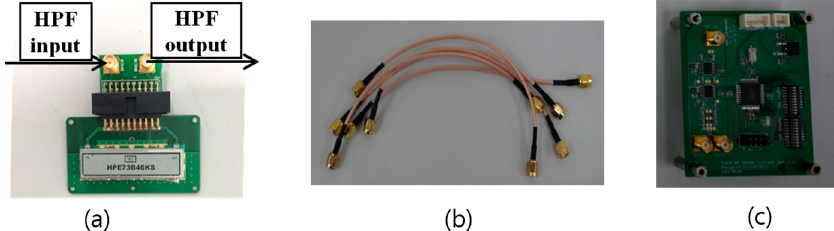
Figure 10. Submodules of IF, ( a ) high-pass filter; ( b ) coaxial cables; ( c ) voltage gain control amplifier (VGA).